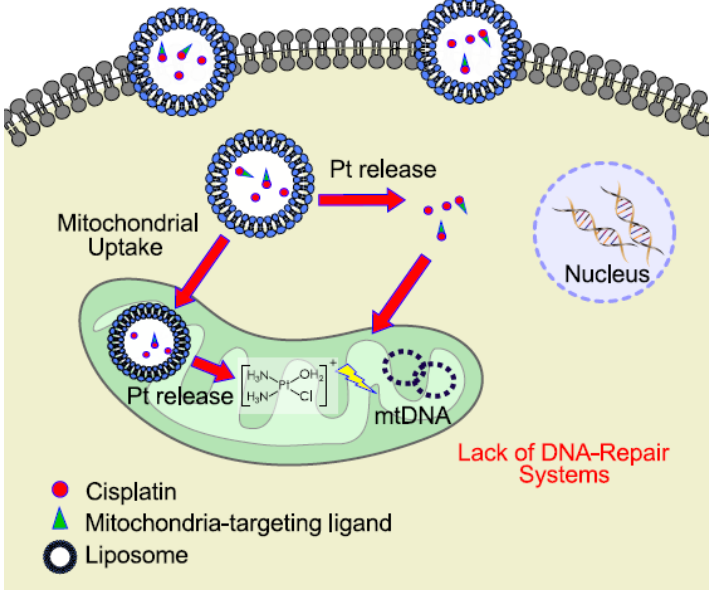
Figure 1. Schematic representation of an example for mitochondrial delivery of cisplatin prodrug using liposomal formulation.